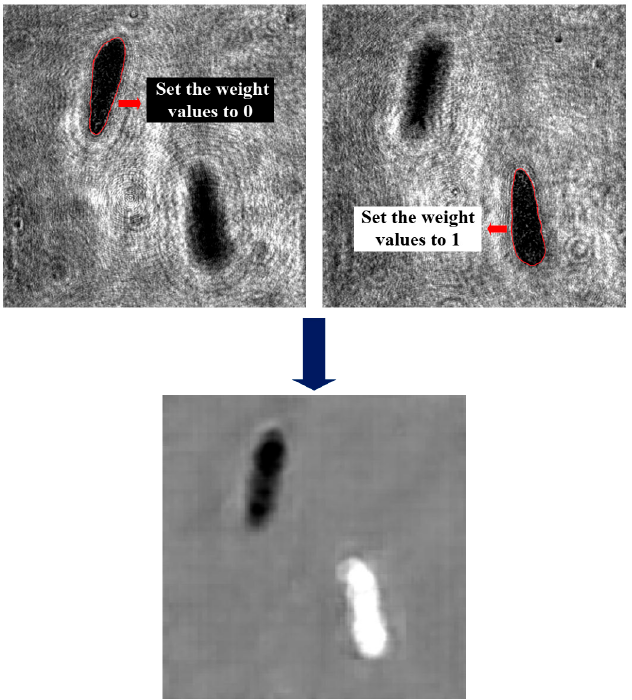
Figure 5. Visual representation of the weight matrix obtained from DHM ‐ FCN.